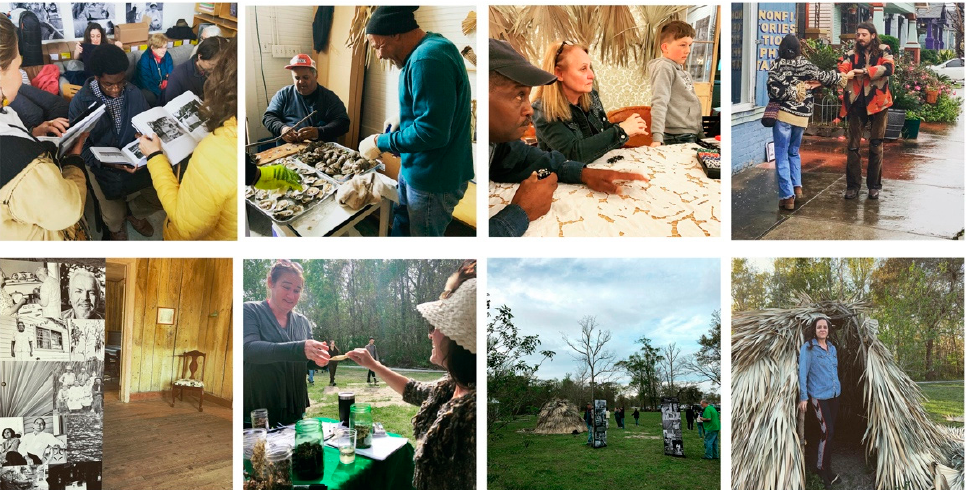
Figure 20. A collage from the exhibit and book release of Monique Verdin’s book, Return to Yakni Chitto. ( Top ): Events at the Neighborhood Story Project’s workshop. ( Bottom ): The exhibit, curated by artist Michel Varisco with poetry by Raymond “Moose” Jackson, at the Land Memory Bank and Seed Exchange’s installation, which included the building of a traditional Houma palmetto hut, at Los Isleños Museum’s annual Fiesta in St. Bernard Parish. Photographs by Rachel Breunlin, courtesy of the Neighborhood Story Project.